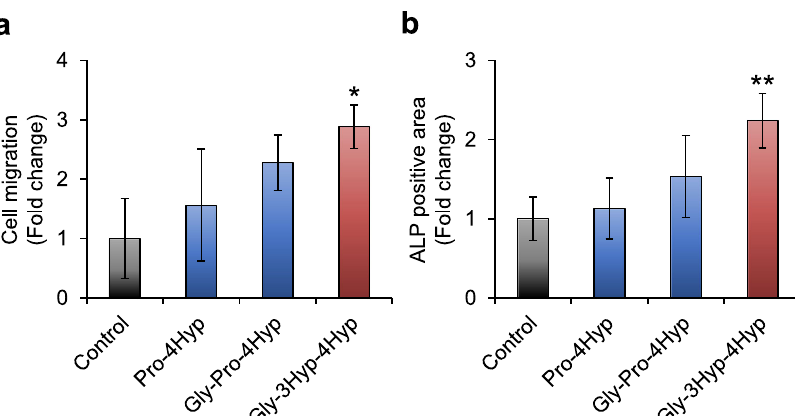
Fig. 6 Fibroblast chemotaxis and osteoblast differentiation induced by Gly-3Hyp-4Hyp. a Migration of human skin fi broblasts through the gelatin-coated fi lter membrane of the transwell insert was evaluated after 18 h of incubation with 0 (control) or 200 nmol/mL of synthetic peptides (Pro-4Hyp, Gly-Pro-4Hyp, or Gly-3Hyp-4Hyp) added to the lower chamber ( n = 3). The migrated cells were labeled with calcein-AM and counted by fl uorescence microscopy. b Osteoblast differentiation was evaluated by ALP staining after culturing mouse pre-osteoblast MC3T3-E1 cells with 0 (control) or 200 nmol/mL of synthetic peptides (Pro-4Hyp, Gly-Pro-4Hyp, or Gly-3Hyp-4Hyp) for 6 days ( n = 6). * P < 0.05 and ** P < 0.01 compared to the control (ANOVA/Dunnett ’ s test). The data represent the mean ±